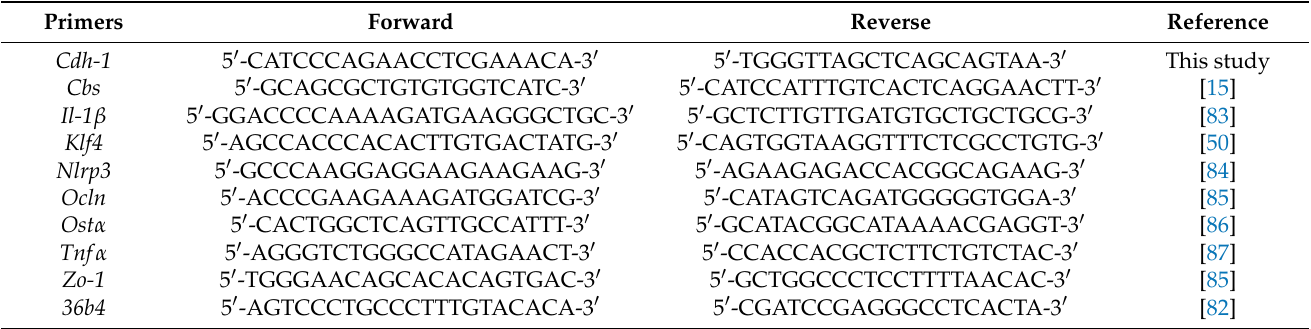
Table 3. Sequences of the oligonucleotides used in the